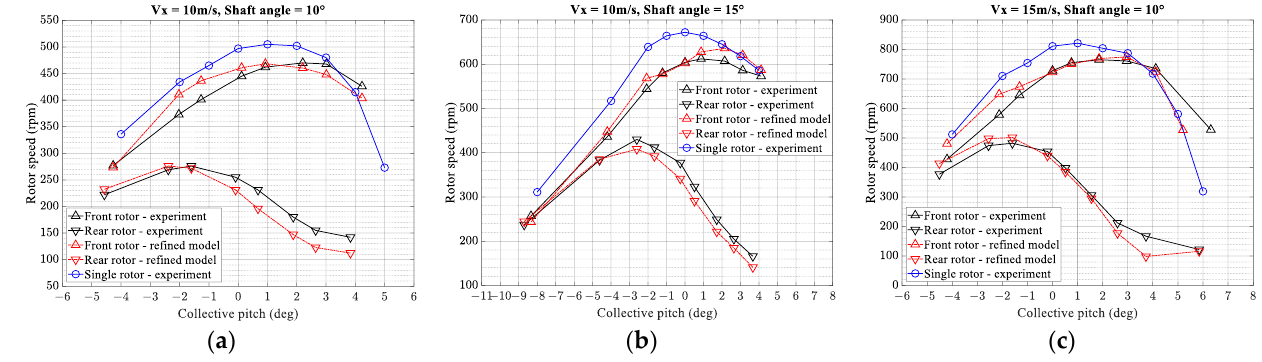
Figure 17. Refined model prediction of steady-state rotor speed of tandem rotor forward flight autorotation at ( a ) V x = 10 m/s, θ = 10 deg; ( b ) V x = 10 m/s, θ = 15 deg; ( c ) V x = 15 m/s, θ = 10